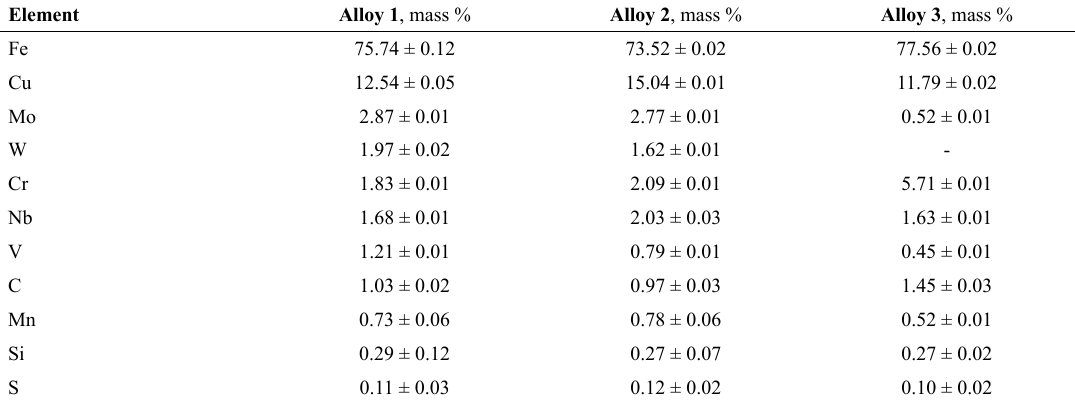
Table 4. Chemical composition of the VSI determined by gas analysis and energy dispersive X-ray fluorescence spectrometry. The carbon and sulfur amounts were determined using the first technique